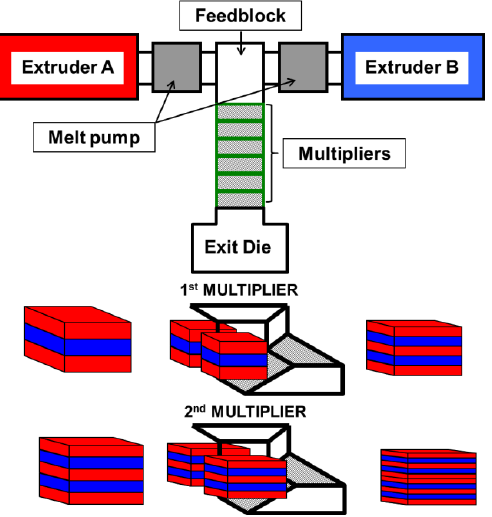
Figure 1 . Schematic illustration of the coextrusion and multiplication line used for the fabrication of the multilayered films.